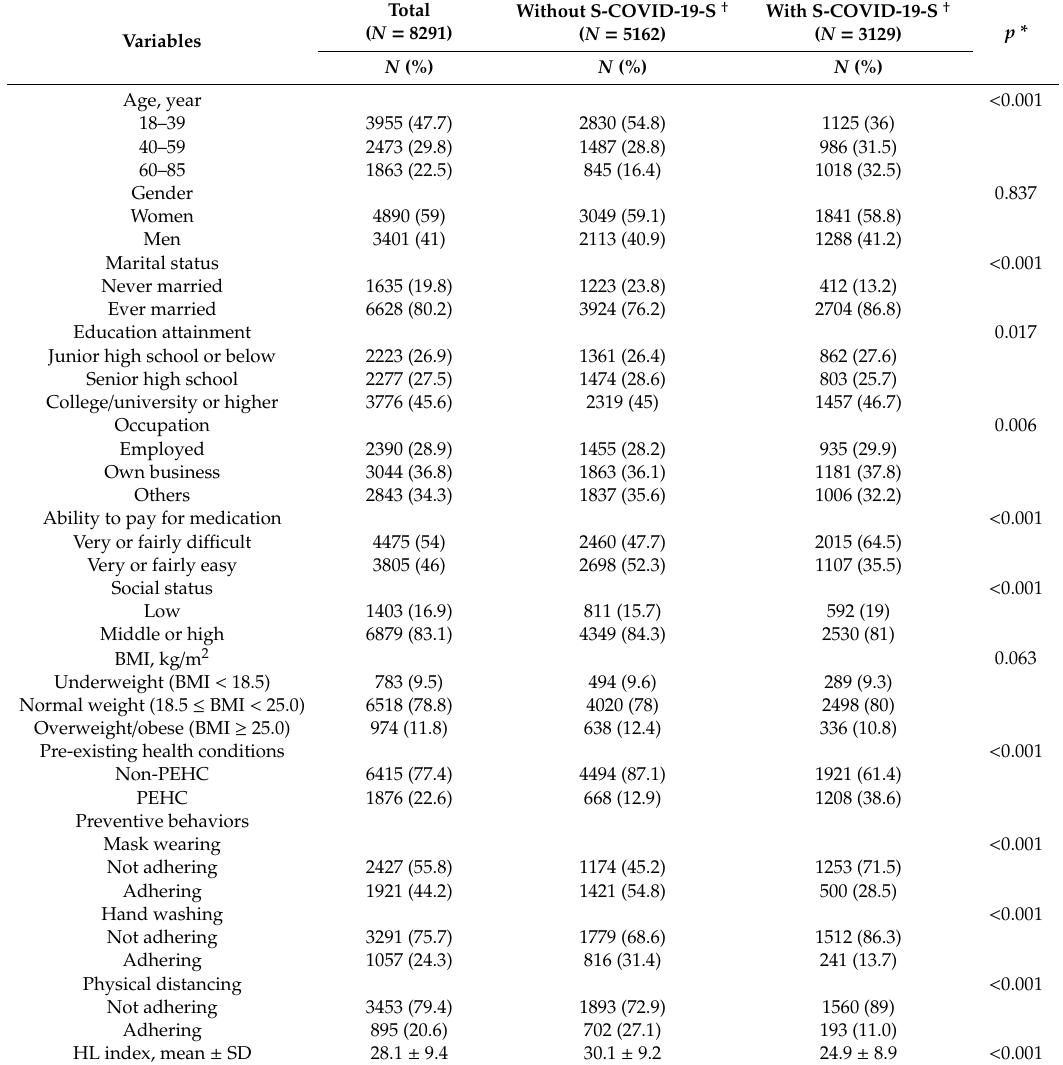
Table 1. Characteristics of studied participants ( N =